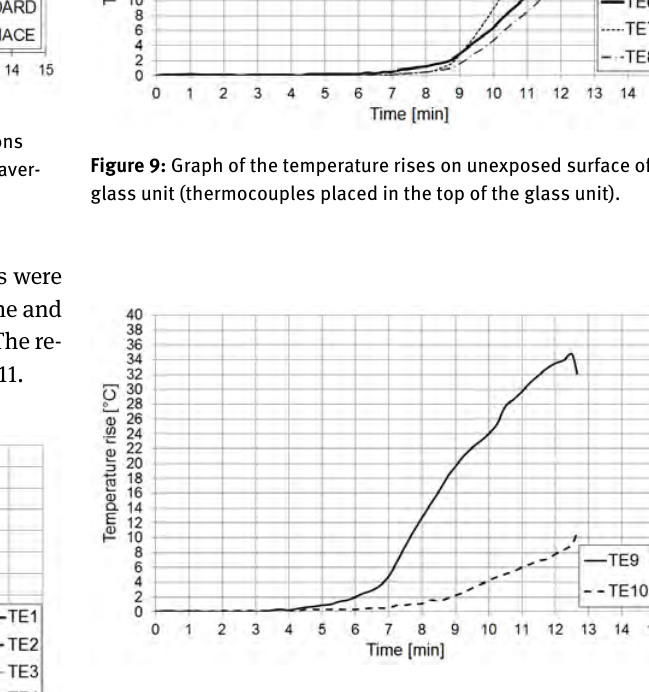
Figure 10: Graph of the temperature rises on unexposed surface of structure